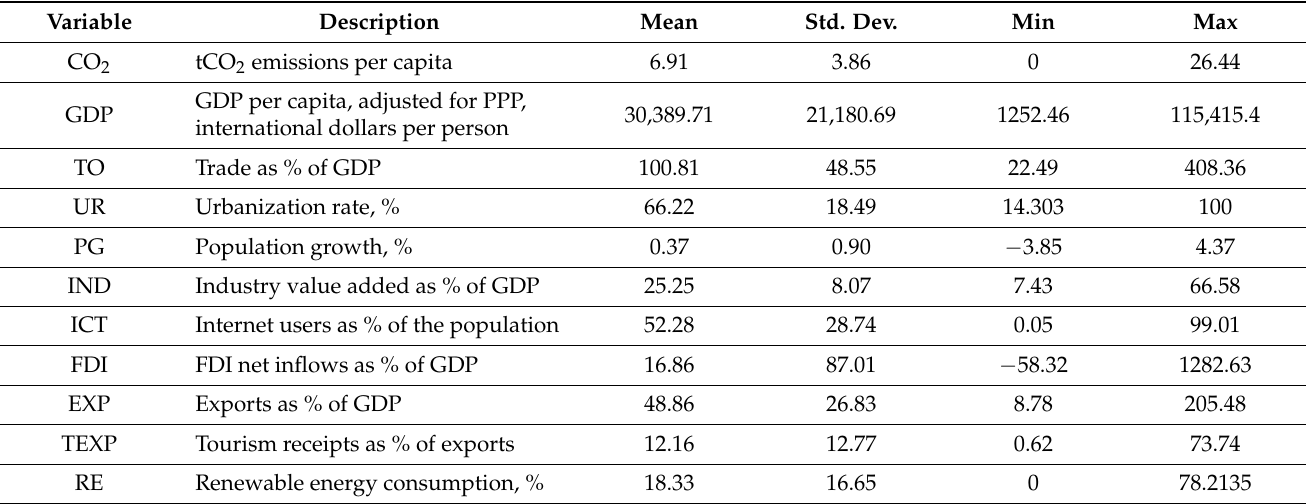
Table 1. Summary